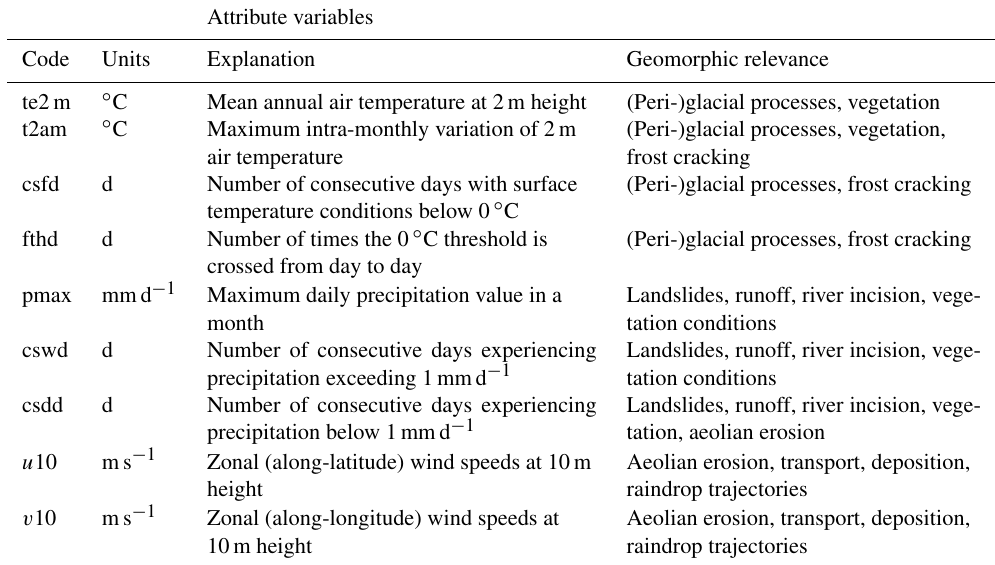
Table 1. Code, units, explanation and geomorphic relevance of each of the climate attribute variables used in the cluster and discriminant